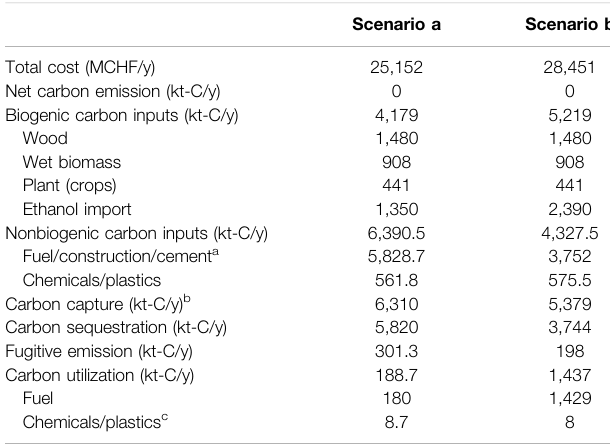
TABLE 4 | Scenario